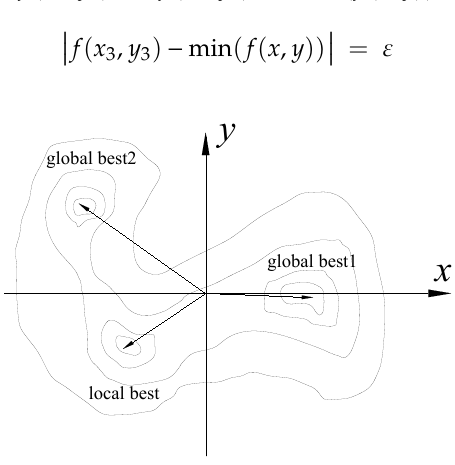
Figure 2. Feasible region of bivariate in model updating.